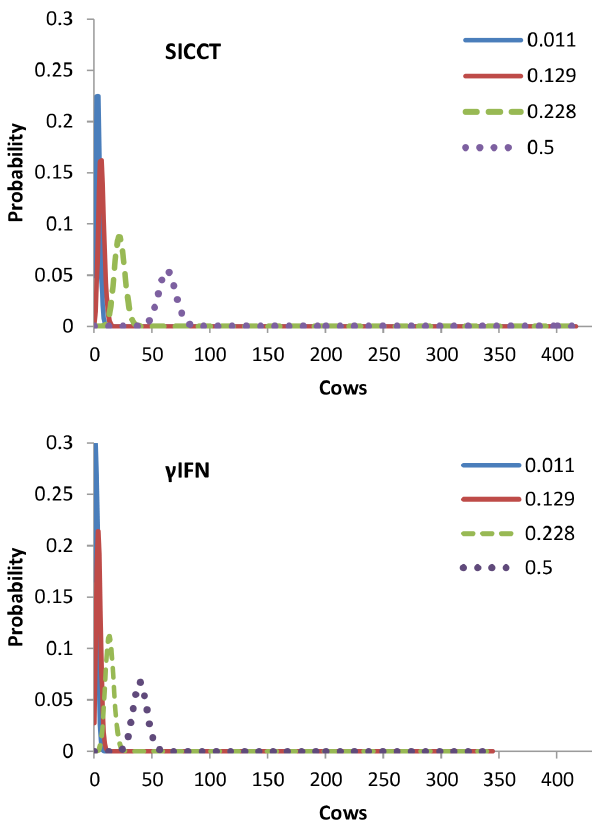
Figure 8. The number of infected cows predicted to have tested negative at Higher Burrow farm. Probability densities are shown with the different colours representing various calculated prevalence levels, the value of which is given. Probability densities at prevalence levels 0.011 and 0.129 overlap. c IFN identified 72 more animals as positives and therefore the herd was reduced by this number before constructing the probability densities.